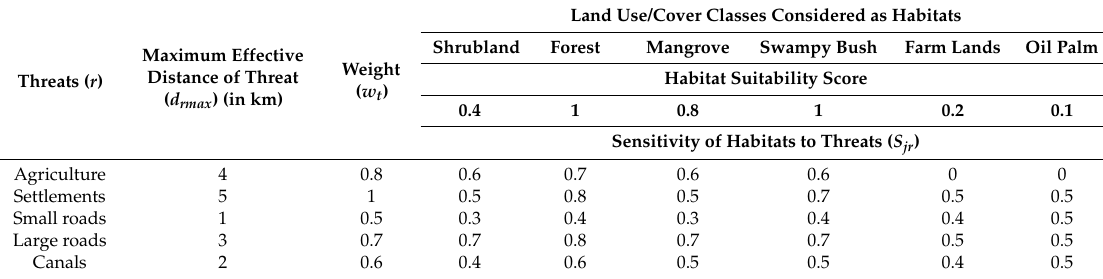
Table A4. Maximum distance, habitat suitability, relative sensitivity of habitats to threats (higher numbers indicate more habitat suitability and more sensitivity to